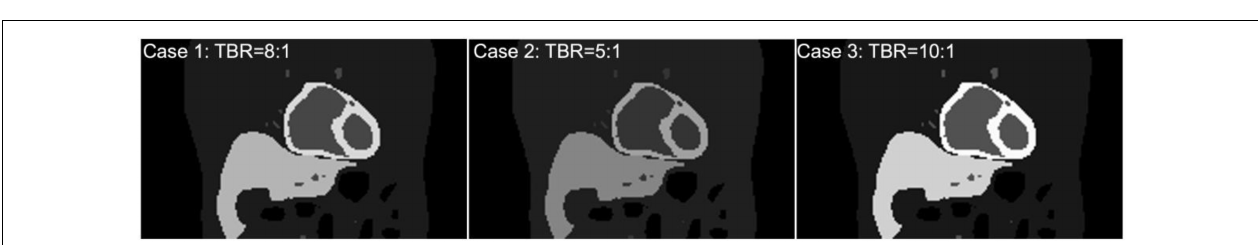
The reconstructed images were then filtered with 4D Gaussian filter (FWHM = 4.5 mm and kernel size =